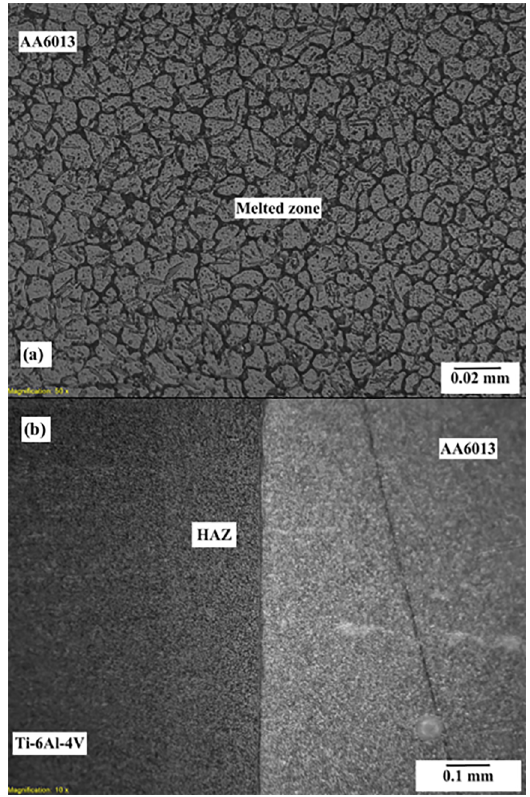
Figure 5. Microstructure of the joint (a) on the side of Al alloy and (b) the heat-affected zone (HAZ) on the side of Ti